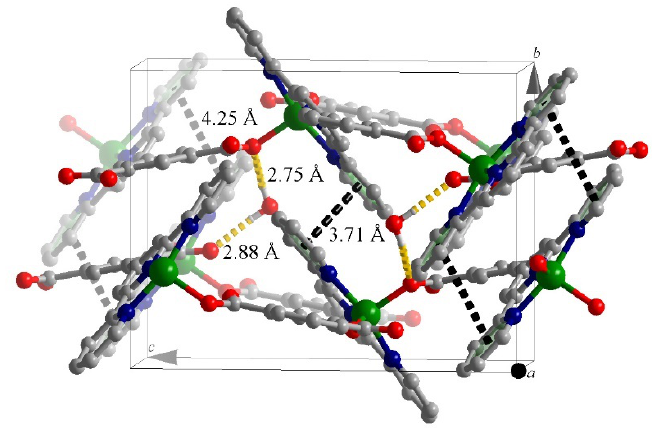
Figure 3. H-bond and π - π stacking as the interlayer force in 1